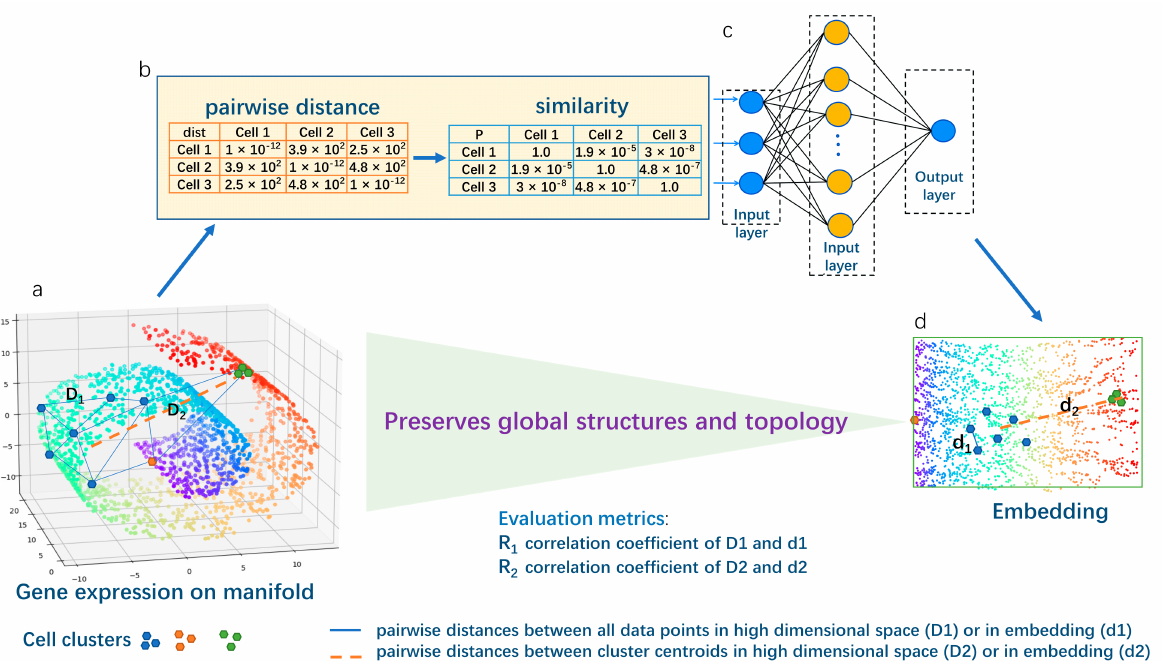
Figure 1. Schematic overview for Panoramap. The 3-dimensional (high dimensional) Swiss roll residing in 2-dimensional (low dimensional) space is frequently used in machine learning to illustrate the topology-preserving dimensionality reduction algorithm. The rainbow color on the Swiss roll denotes coordinates or positions of the points. A perfect dimension reduction method can unfold the Swiss roll and retain the relationships of the coordinates (preserve the structures). ( a ) The gene expression data (the blue, green and orange points are shown as illustration) are high dimensional data residing on low dimensional biological manifolds. Each point represents one cell with multiple genes. Cells from one cell type can form a cell cluster (e.g., the blue points form a cluster with high